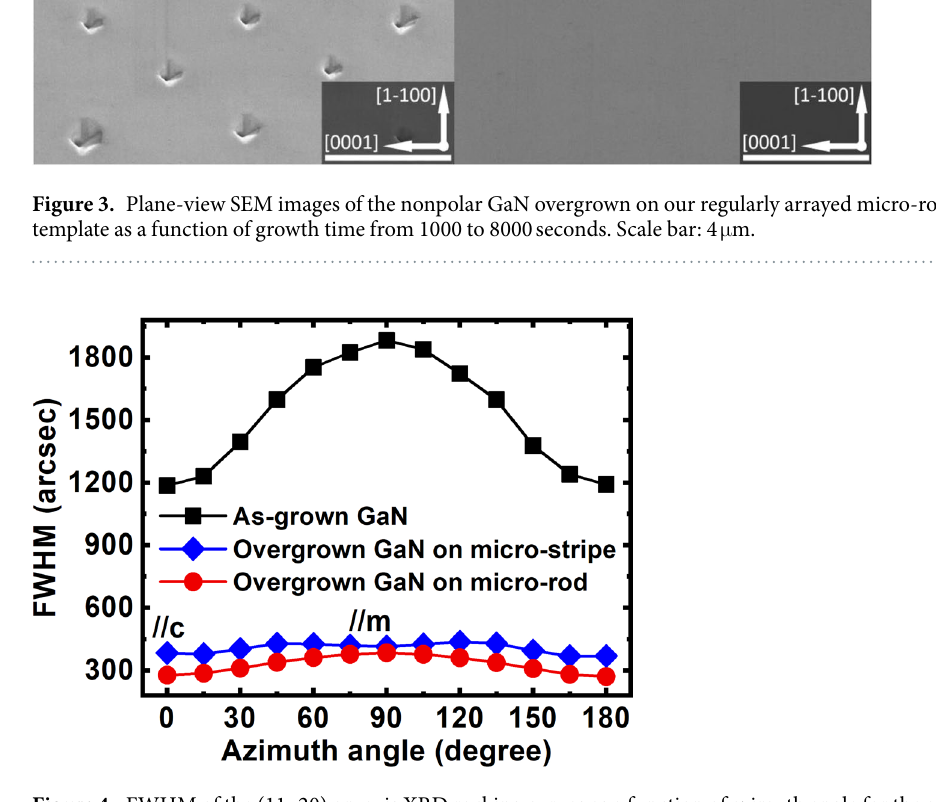
Figure 4. FWHM of the (11–20) on-axis XRD rocking curves as a function of azimuth angle for the as-grown sample, the overgrown GaN on our regularly arrayed micro-rod template, and the overgrown GaN on the standard stripe-pattern